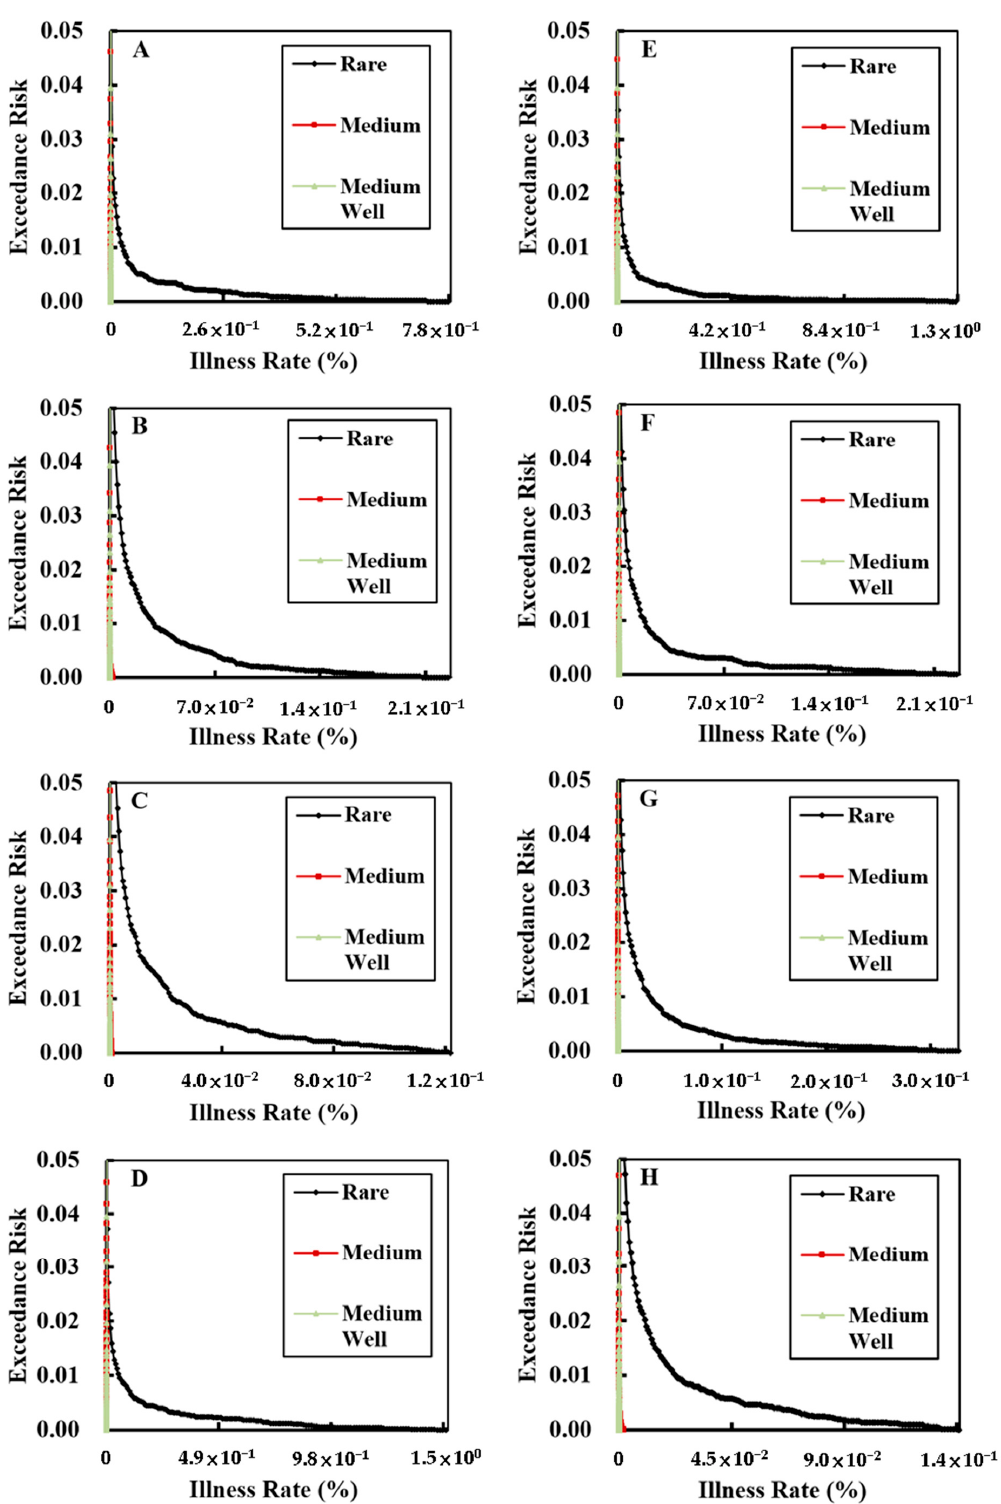
Figure 3. Exceedance risk to the Taiwanese population from consuming beef imported from the United States of America. ( A ) Males and females aged 4–12 years, ( B ) males aged 13–18 years, ( C ) females aged 13–18 years, ( D ) males aged 19–65 years, ( E ) females aged 19–65 years, ( F ) males aged > 65 years, ( G ) females aged > 65 years, and ( H ) females aged 19–49 years (of childbearing